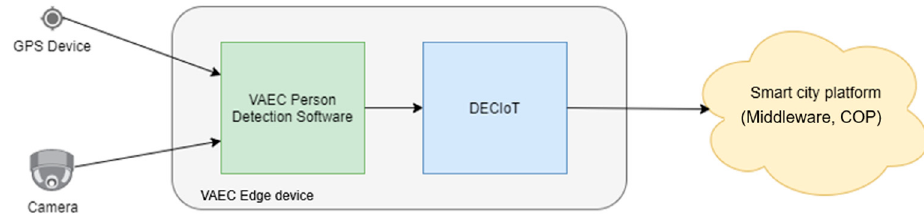
Figure 1. VAEC Architectural